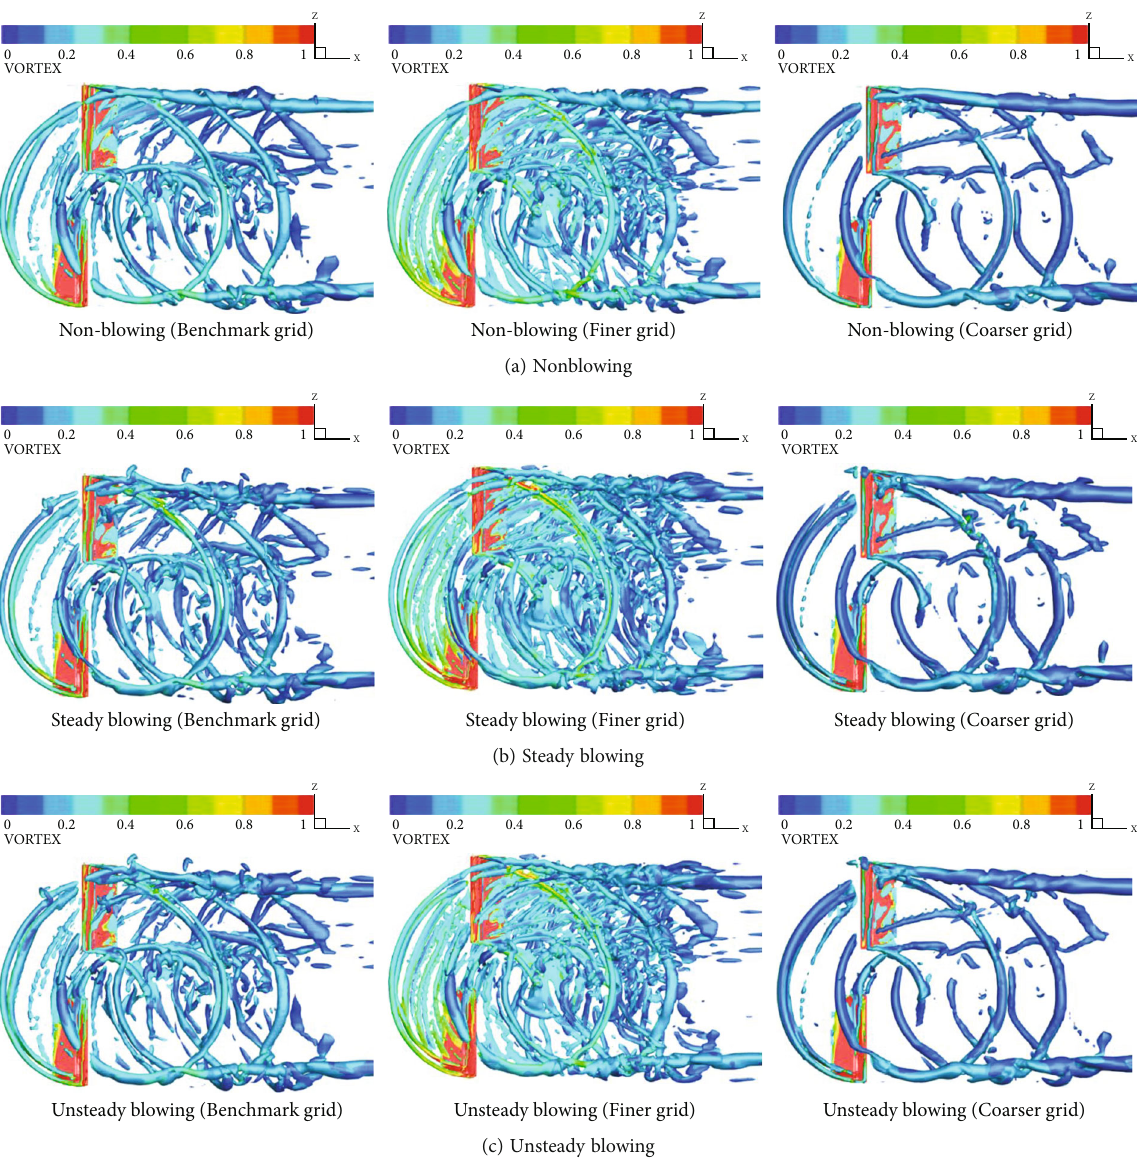
Figure 7: Rotor wake for the steady/unsteady blowing cases under the three background grid resolutions (isosurfaces of the Q criterion at Q = 0 : 001 , colored by vorticity